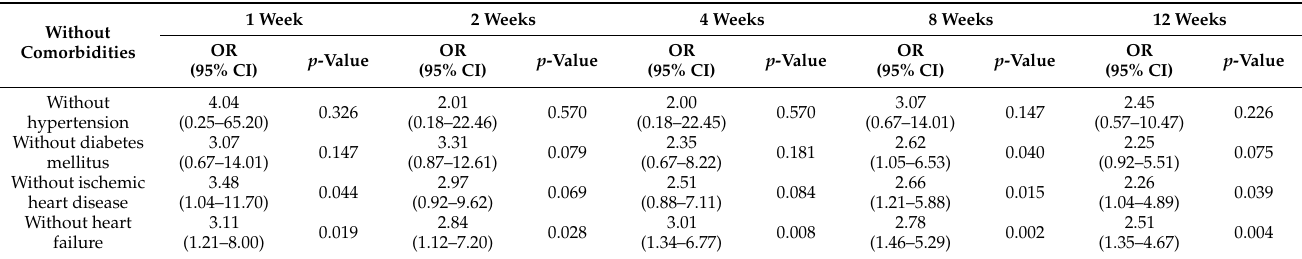
Table 4. Association of bowel preparation and subsequent colonoscopy with new-onset atrial fibrilla- tion in patients without